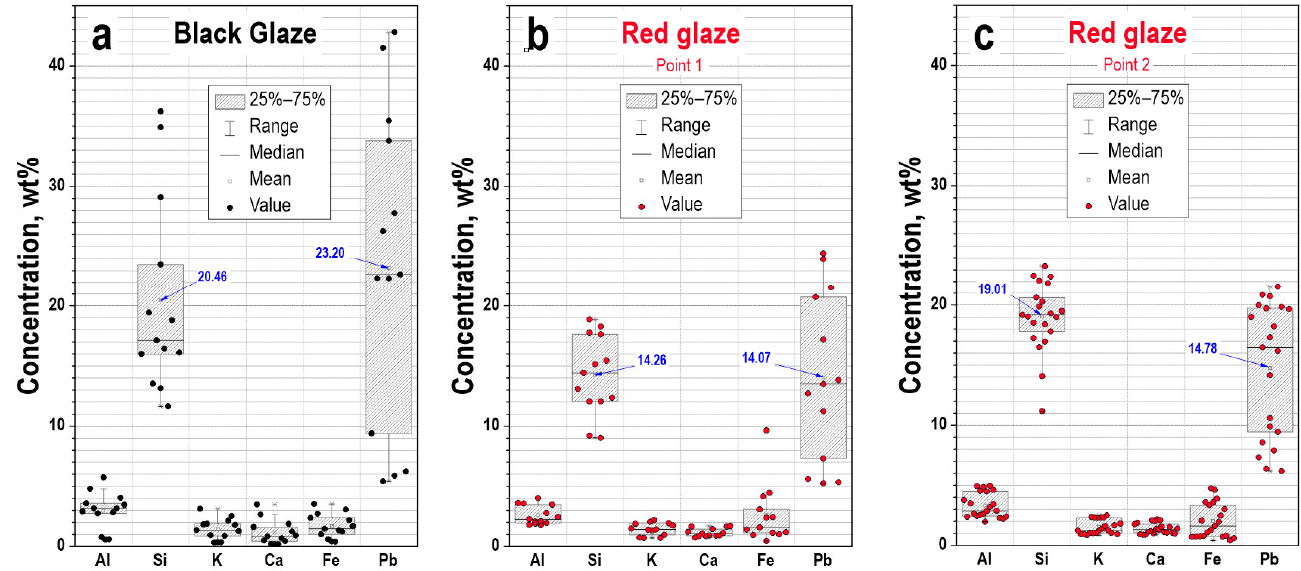
Figure 11. Box-and-whiskers plots for chemical compositions of black glaze ( a ) and red glaze at point 1 ( b ) and point 2 ( c ).